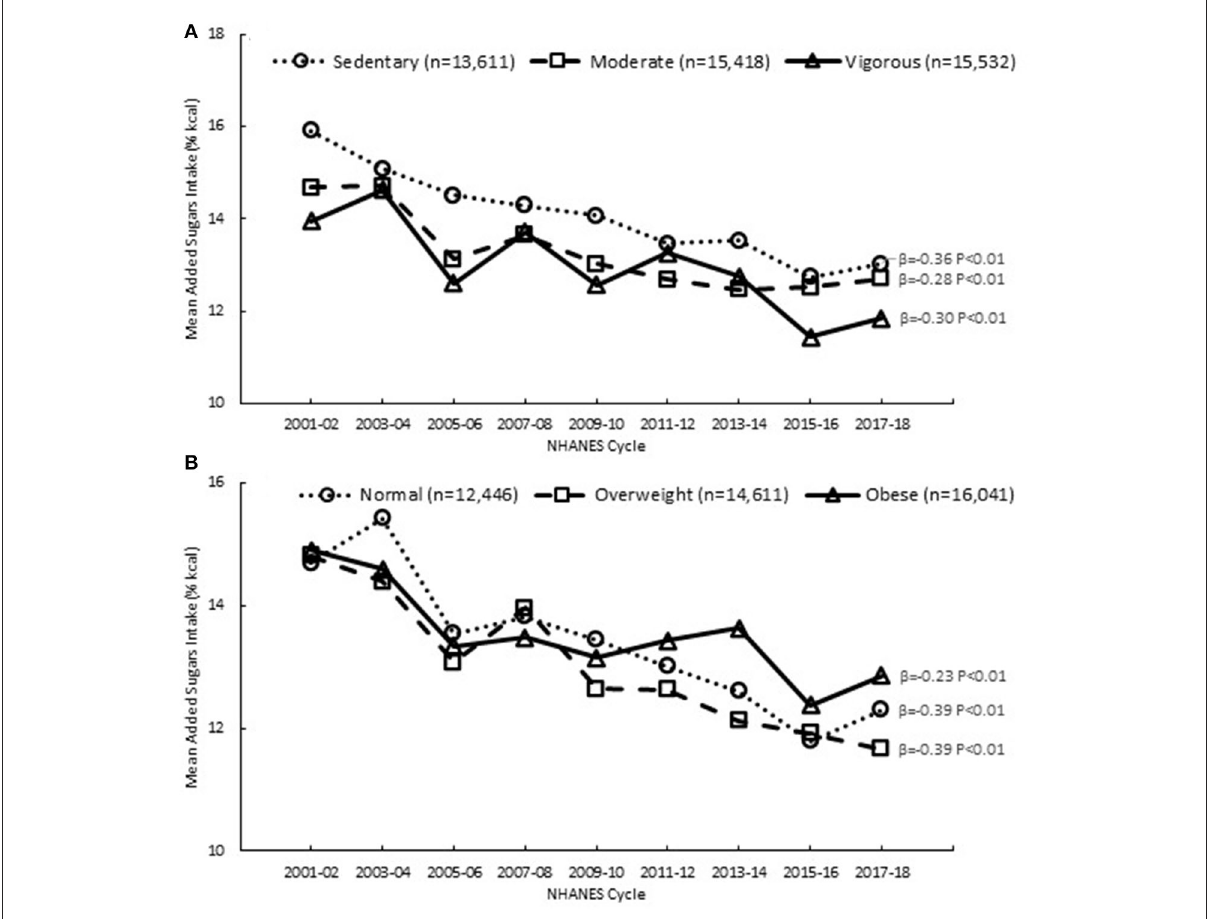
FIGURE3 Added sugars intake among adults (19 + y), 2001–2018, by (A) physical activity level and (B) body weight status, based on first day of dietary recall; β and P -values from linear trend analysis, significant at P < 0.01; Source NHANES 2001–02 to 2017–18.